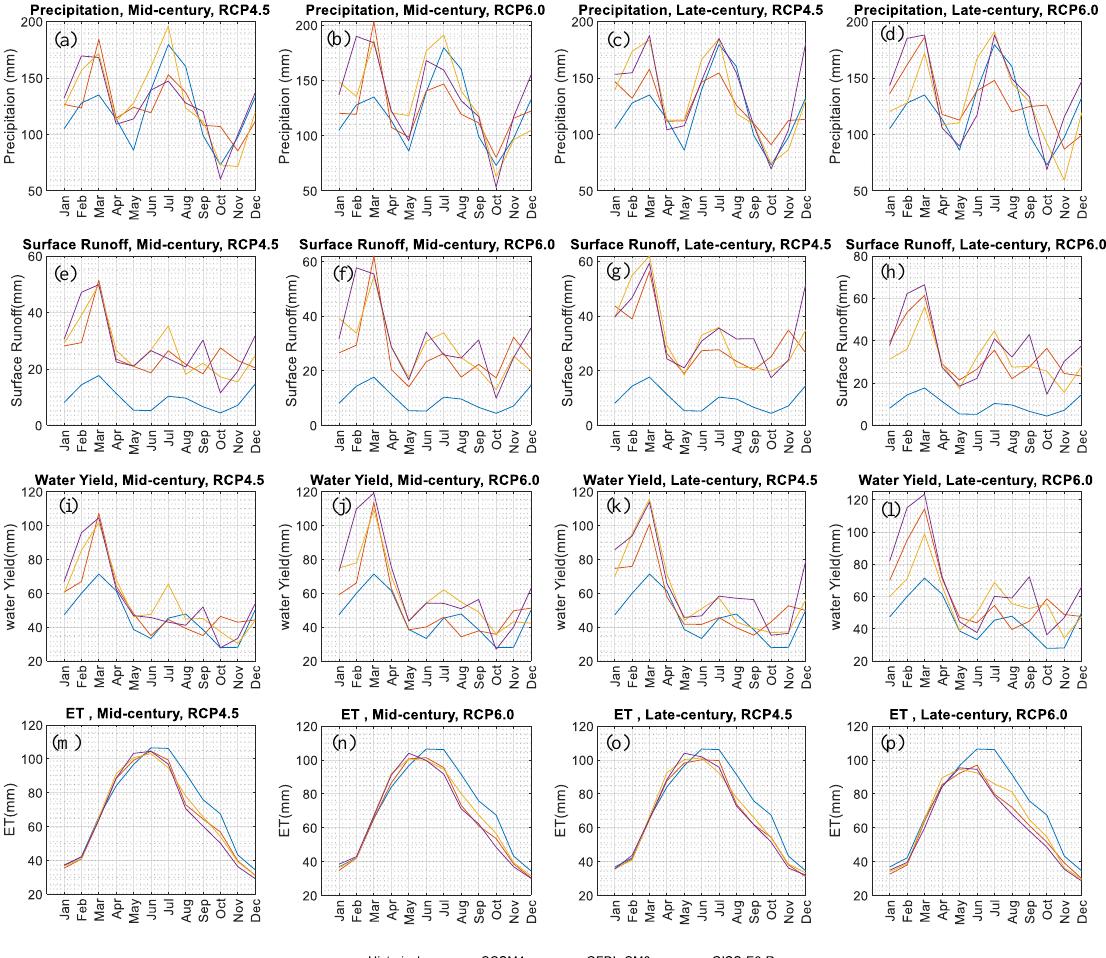
Figure 9. Projected and historical monthly average of hydrological components in UCS based on the models and under RCP4.5 and RCP6.0. The top panel shows projected monthly average rainfall for each scenario and period separately ( a , b , c , d ). The second panel from the top, presents projected monthly average surface runoff for each scenario and period separately ( e , f , g , h ). The third panel from the top, presents projected monthly mean water yield for each scenario and period separately ( i , j , k , l ). The bottom panel illustrates projected monthly average ET for each scenario and period separately ( m , n , o , p ).